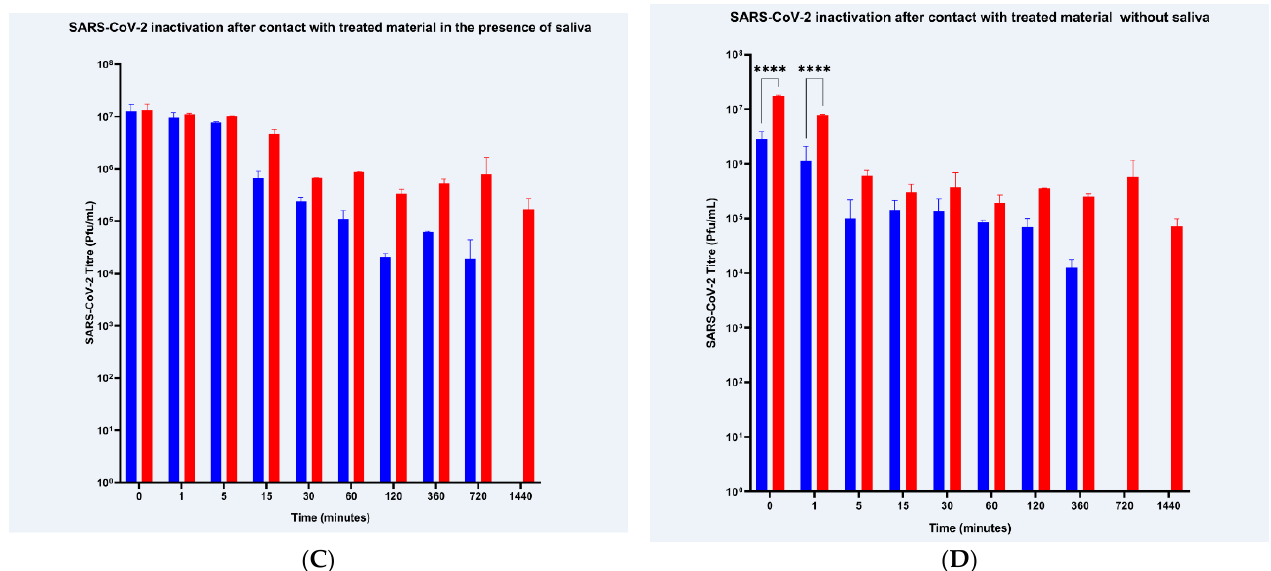
Figure 1. Inactivation of H1N1 and SARS-CoV-2 when in contact with a Viruferrin treated fabric material. 20 mm × 20 mm pieces of treated (Viruferrin-treated) and untreated (Cotton) control fabric samples, with ( A , C ) and without ( B , D ) the application of saliva, were assessed for anti-viral capabilities at 10 timepoints over a total time period of 1440 min with a limit of detection below 10 3 PFU. The bars represent geometric mean titers and the standard deviations are shown with error bars. Data was analyzed for significance using a 2-way ANOVA with Sidak’s multiple comparisons test (alpha = 0.05, p **** ≤ 0.0001 with * p value = 0.0162) comparing Viruferrin-treated and cotton control fabric samples at each timepoint.